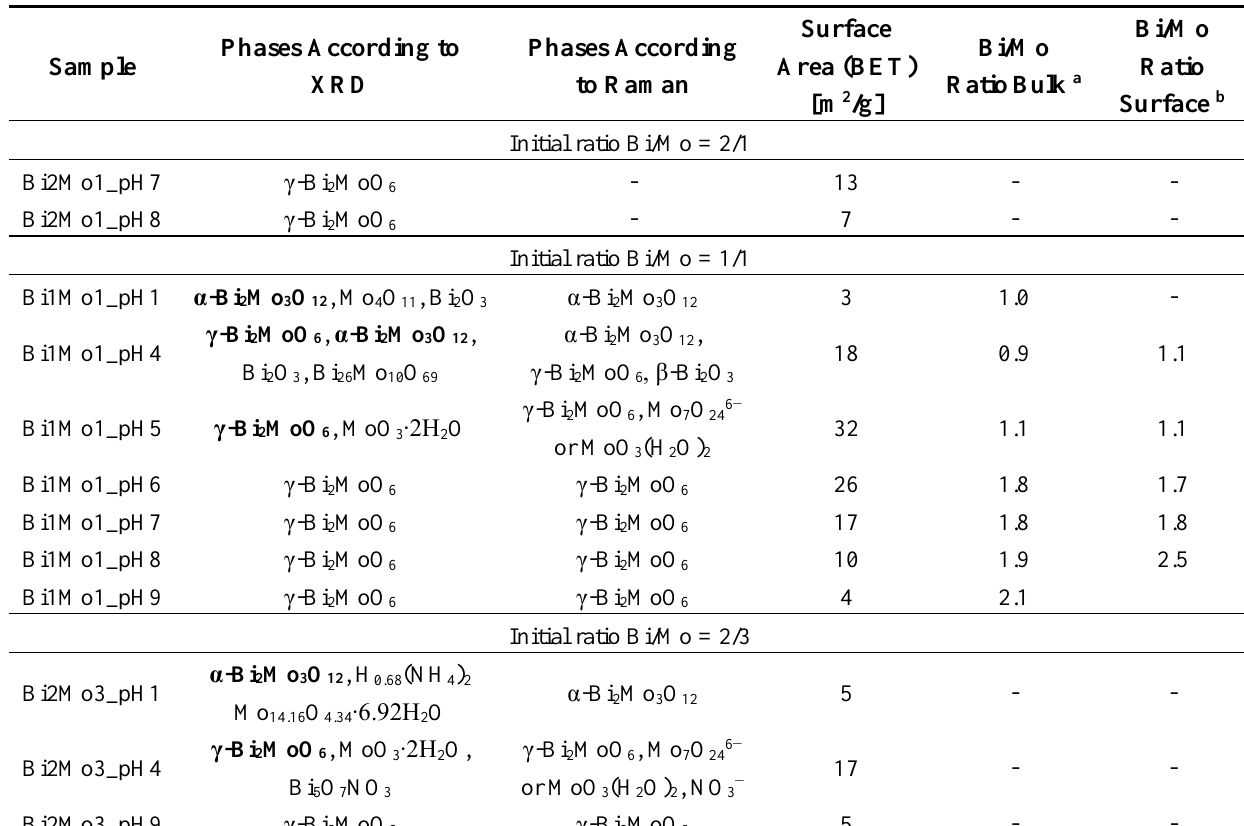
Table 1. Characterization of the samples prepared by hydrothermal synthesis with different Bi/Mo ratios and at various pH values by X-ray diffraction measurements and Raman spectroscopy, as well as nitrogen physisorption measurements (BET), ICP-OES and XPS (main phases in bold